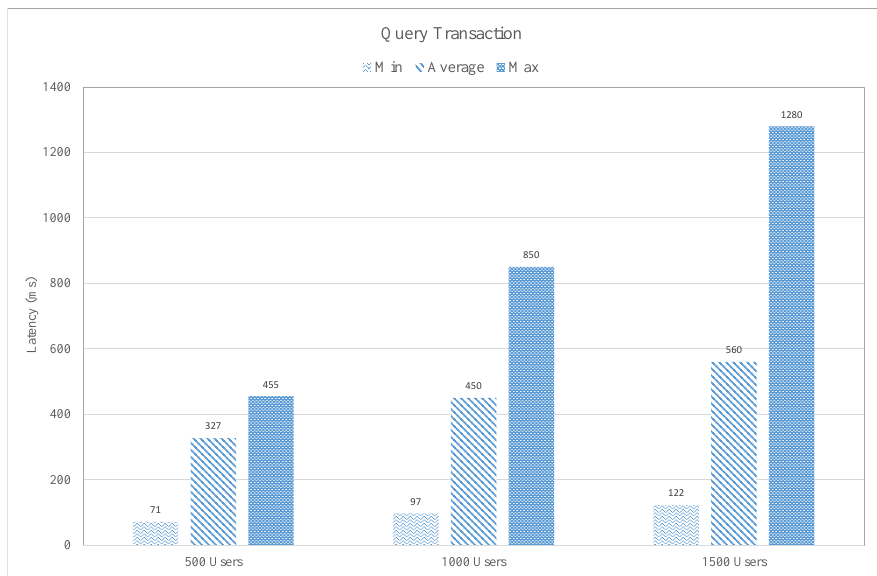
Figure 14. Query Transaction Latency.